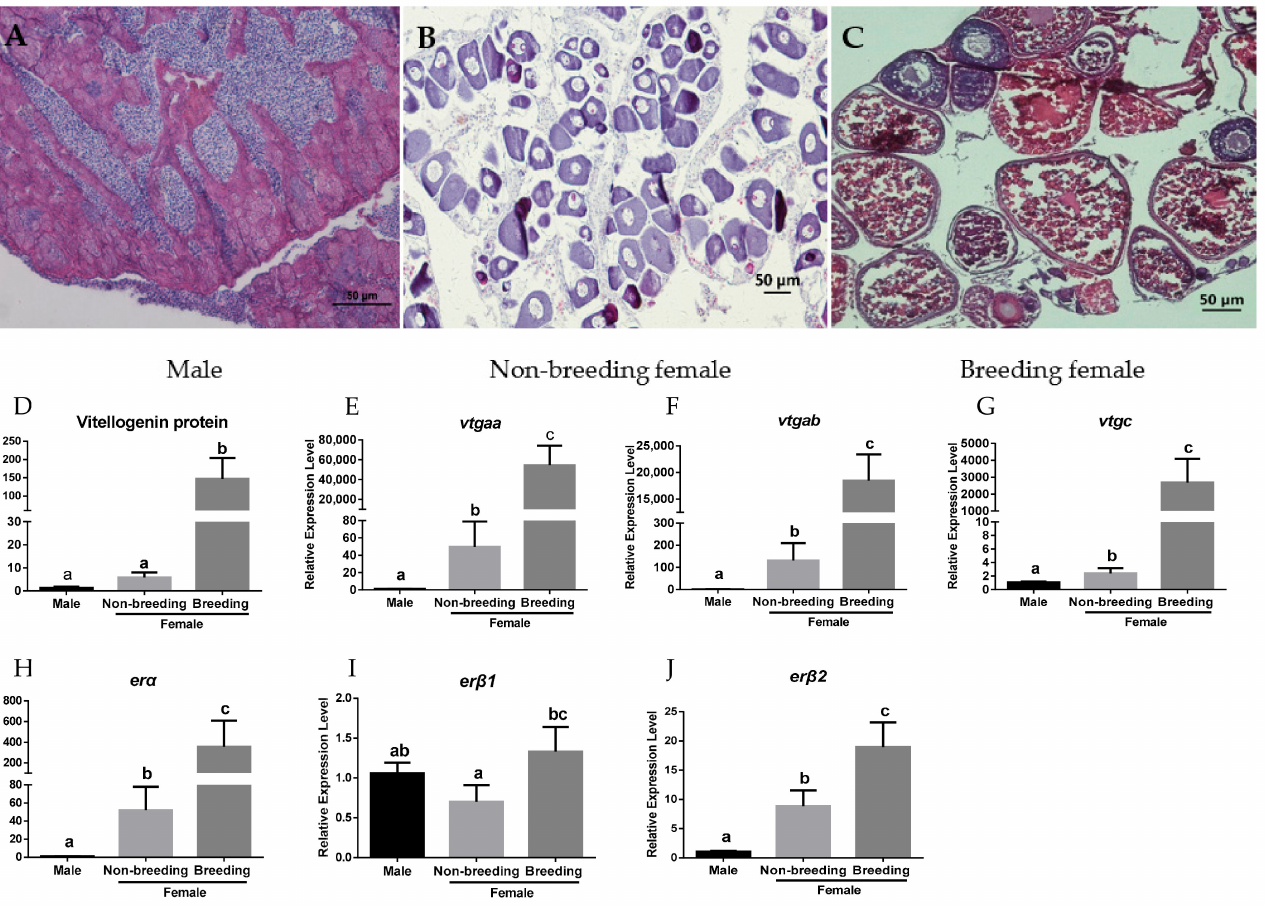
Figure 1. Gonad histology and expression profiles of vtgs and ers in the livers of male and female groupers: ( A ) male testis ( n = 6) with active spermatogenesis; ( B ) non-breeding female ovaries ( n = 6) with primary oocytes; ( C ) breeding female ovaries ( n = 6) with vitellogenic oocytes; ( D ) VTG protein levels in the liver of males and females; ( E – J ) the mRNA levels of vtgaa , vtgab , vtgc , er α , er β 1, and er β 2 in the liver of males and females. Data are expressed as the mean ± SEM ( n = 6) and analyzed by one-way ANOVA followed by Tukey’s post-hoc test. Different letters above the error bars indicate statistical differences at p <